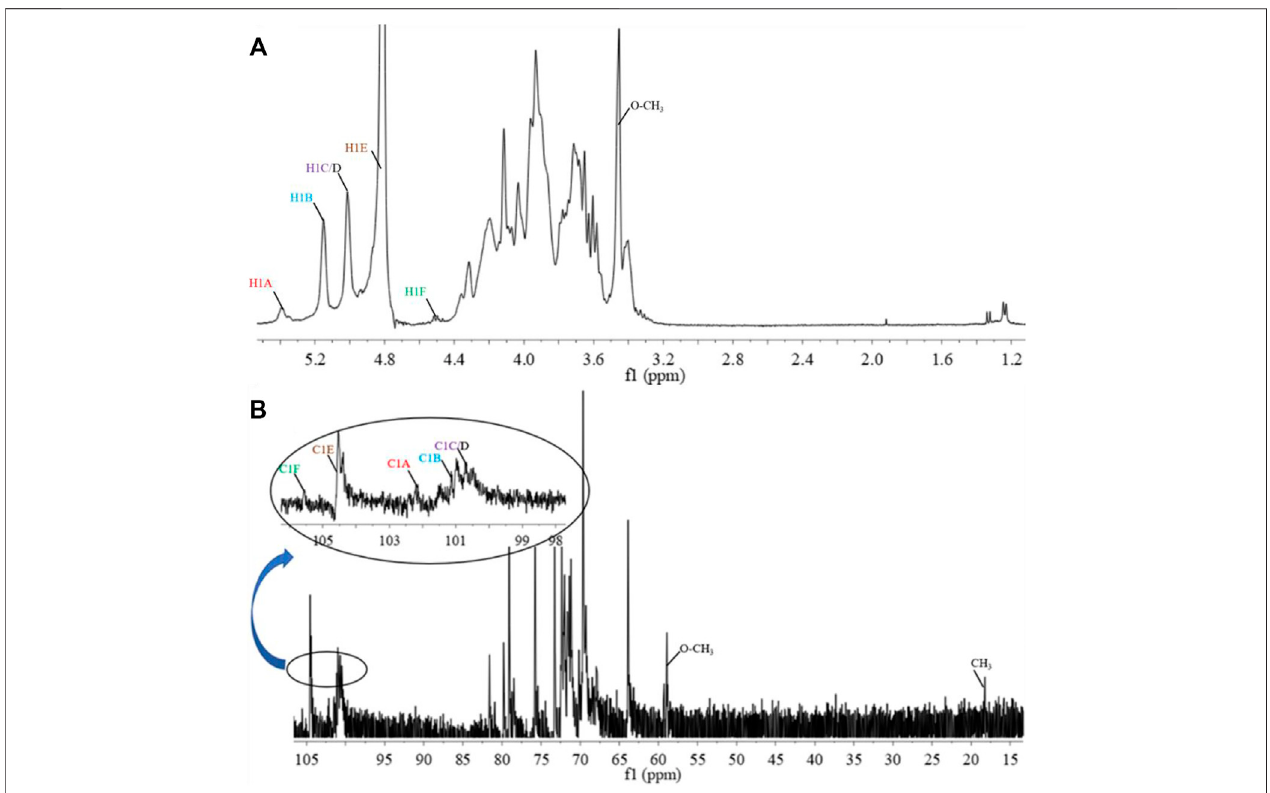
FIGURE 5 | 1 D and 2 D NMR spectrum of PPp-W. 1 H-NMR spectrum (A) , 13 C-NMR spectrum (B) , 1 H – 1 H correlation spectroscopy (C) , 1 H- 13 C heteronuclear single-quantum coherence spectroscopy (D)